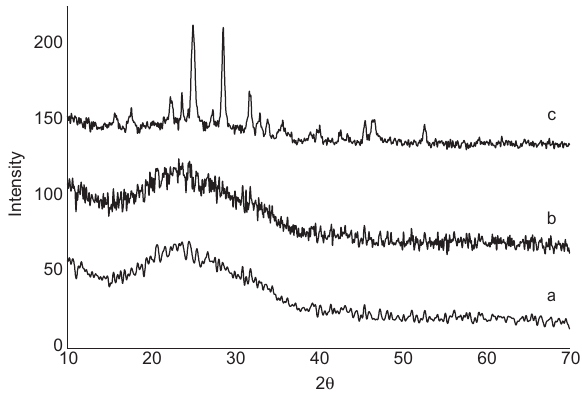
Figure 3 XRD patterns of Bi and (c) after sintering of the powder obtained from (4) at 150 ° C for ∼ 10